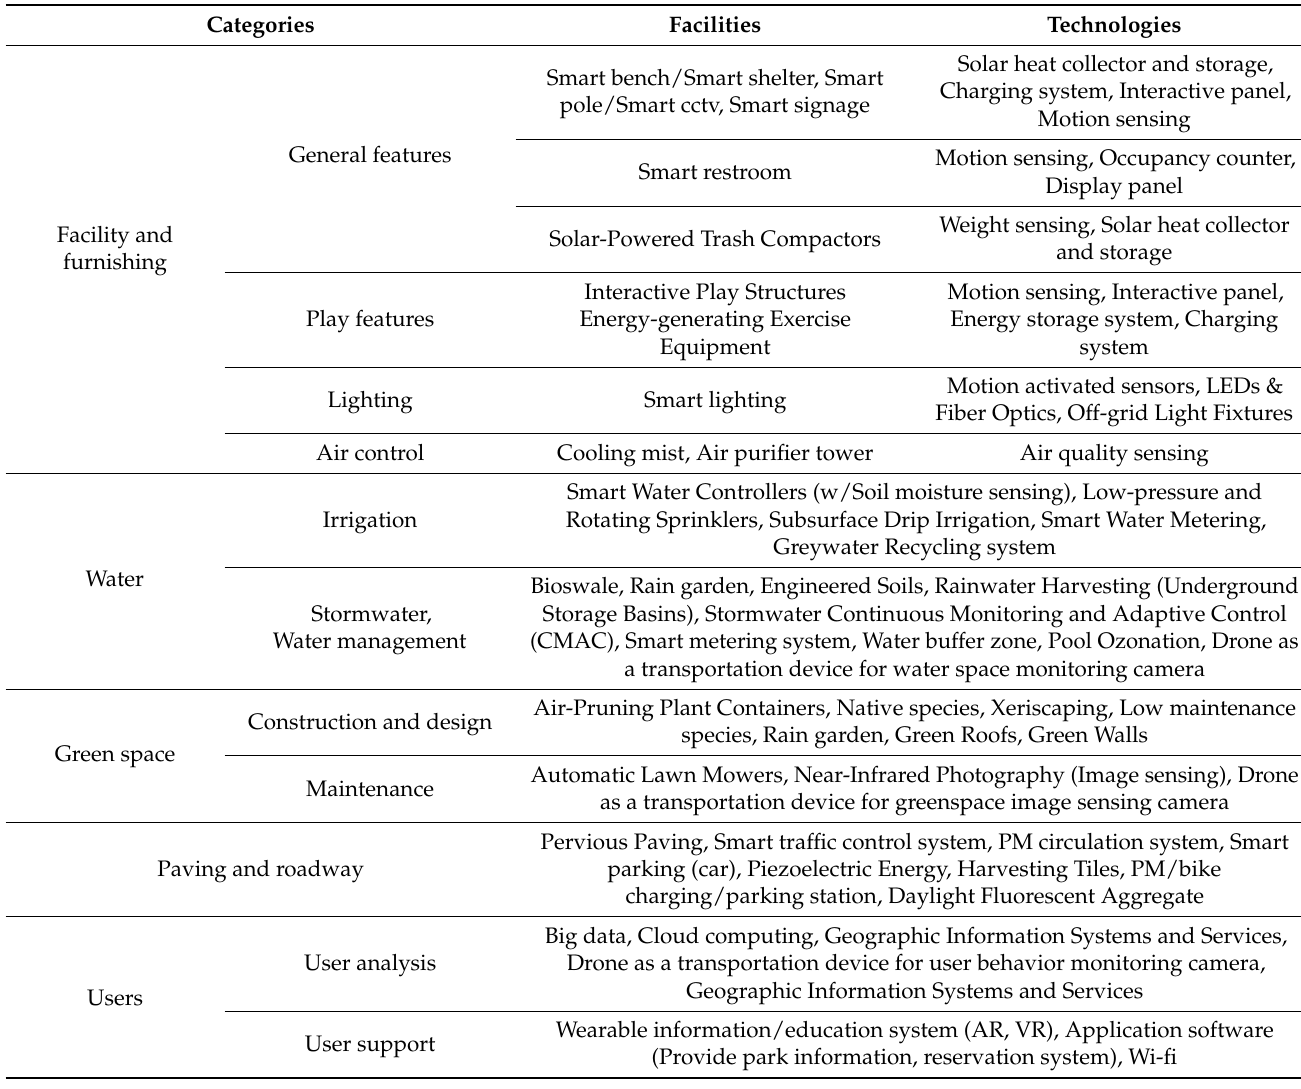
Table 2. Smart technologies that can be applied to park